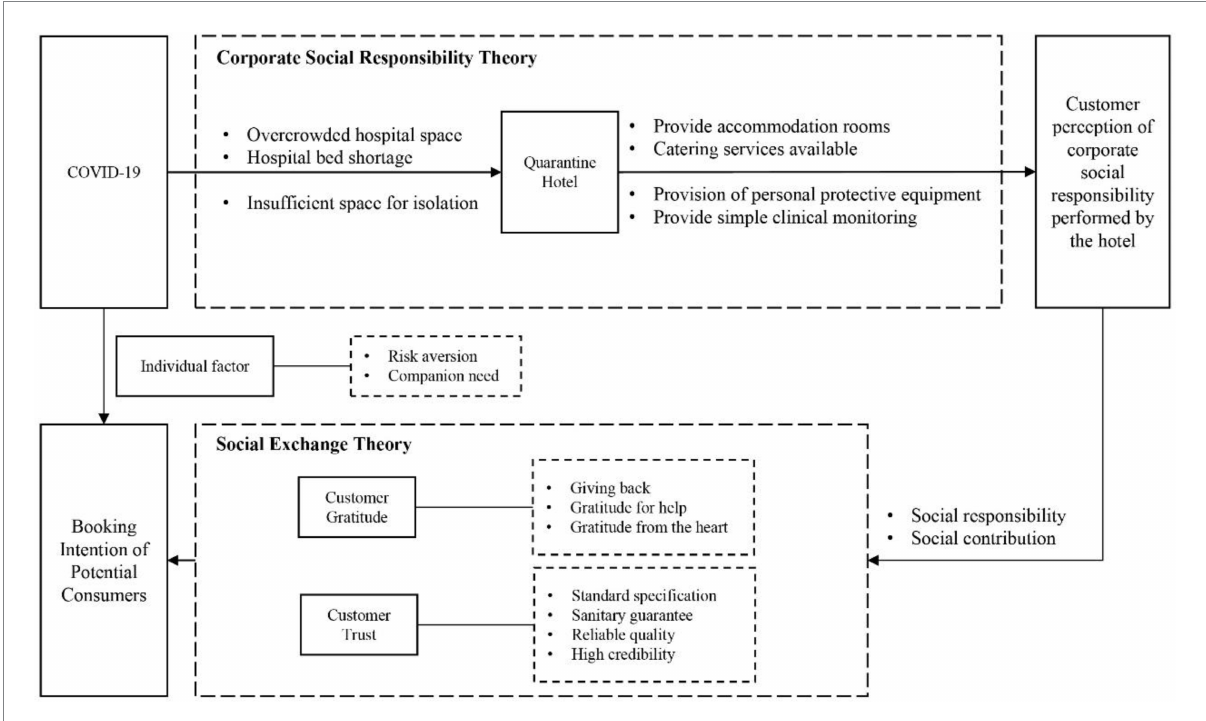
FIGURE 1 The formation path of potential consumers booking intention of Quarantine